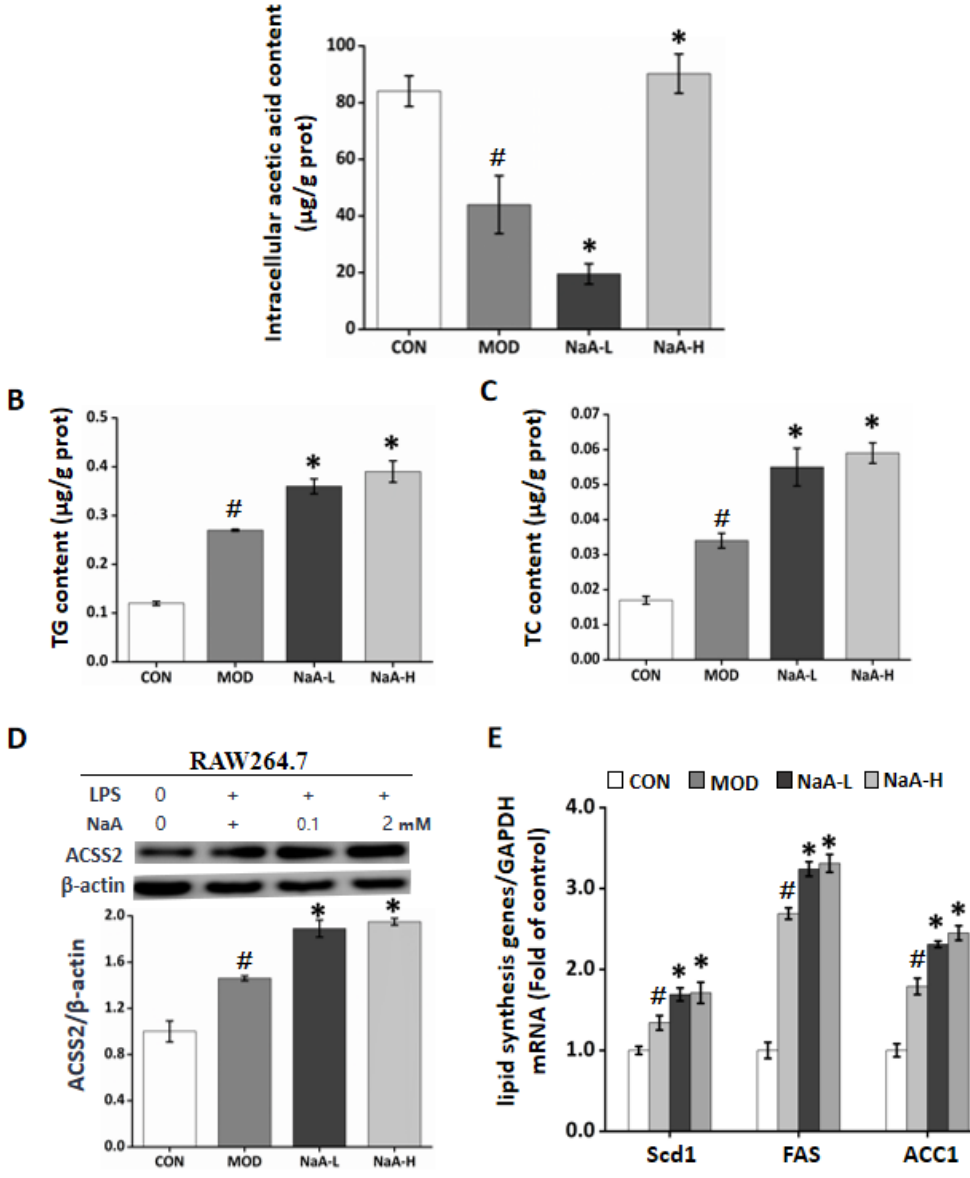
Figure 4. NaA alters intracellular free acetate content by promoting lipid synthesis in macrophages in a dose-related manner. ( A ) NaA regulated intracellular acetic acid content in a dose-dependent manner. ( B ) NaA increased intracellular TG content. ( C ) NaA increased intracellular TC content. ( D ) NaA enhanced the expression of ACSS2 protein, determined by Western Blot ( E ) qRT-PCR showed that NaA increased mRNA expression of lipid synthesis genes ( Scd1 , FAS , ACC1 ). For all bar graphs, data are the mean ± SD, # p < 0.05, as compared with CON, and * p < 0.05, as compared with MOD. The significant difference was assessed using the one-way ANOVA followed by LSD post-tests. Control group (CON), group model cell treated with an LPS (MOD), 0.1 mM sodium acetate group (NaA-L), 2 mM sodium acetate group (NaA-H), arbitrary unit